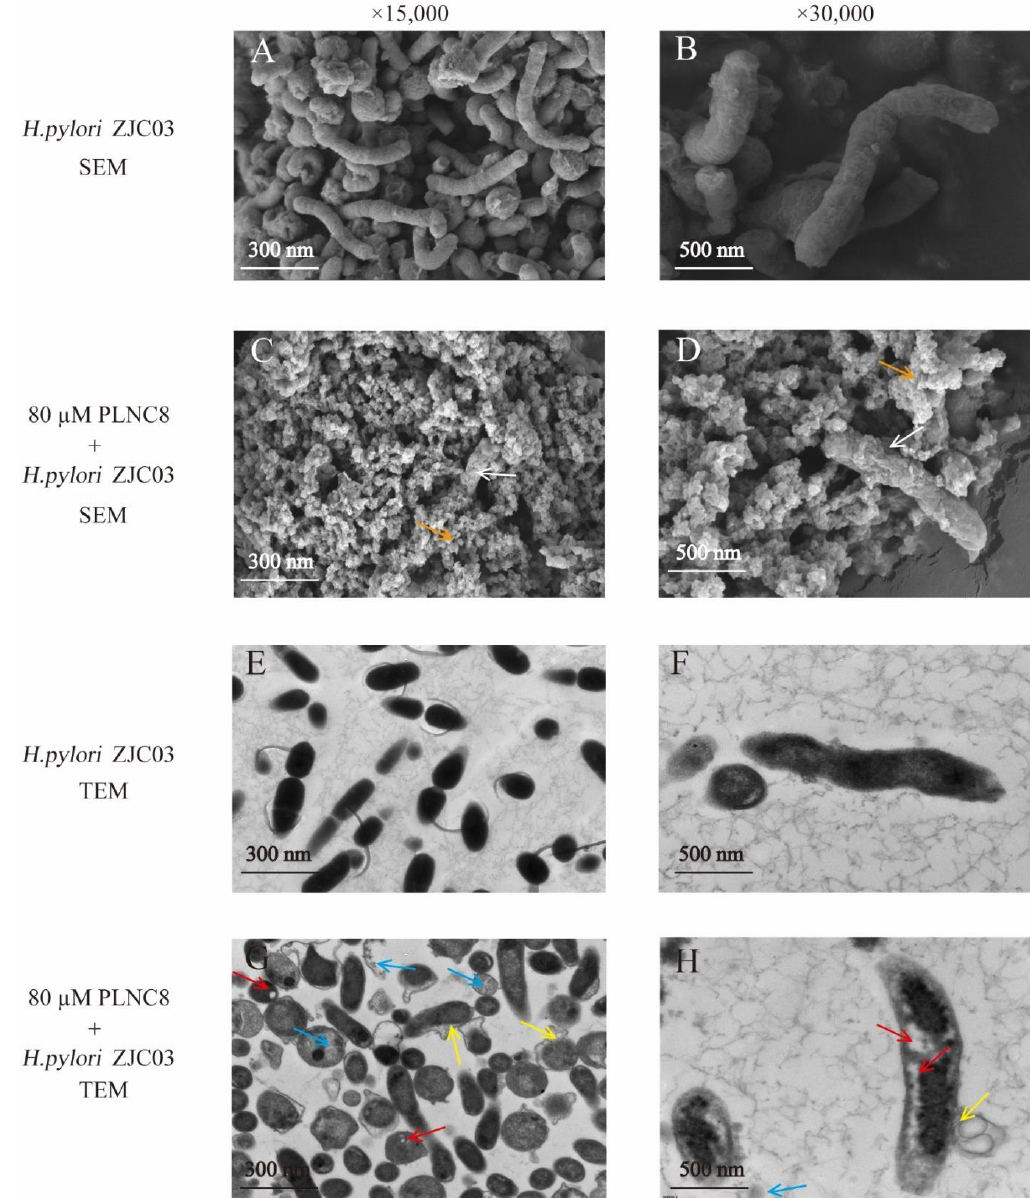
Figure 4. SEM and TEM were used to observe the microscopic structural changes in H. pylori ZJC03 treated with PLNC8 after 4 h at 37 °C. SEM (×15,000) observation is shown in pictures ( A , C ). SEM (×30,000) observation is shown in pictures ( B , D ). TEM (×15,000) observation is shown in pictures ( E , G ). TEM (×30,000) observation is shown in pictures ( F , H ). ( A , B , E , F ) H. pylori ZJC03 cells without treatment. ( C , D , G , H ) H. pylori ZJC03 cells treated with PLNC8. Broken cytoplasm (blue arrow), cell wall separation (yellow arrow), cell collapse (white arrow), cell lysis (orange), and cell perforation (red arrow).